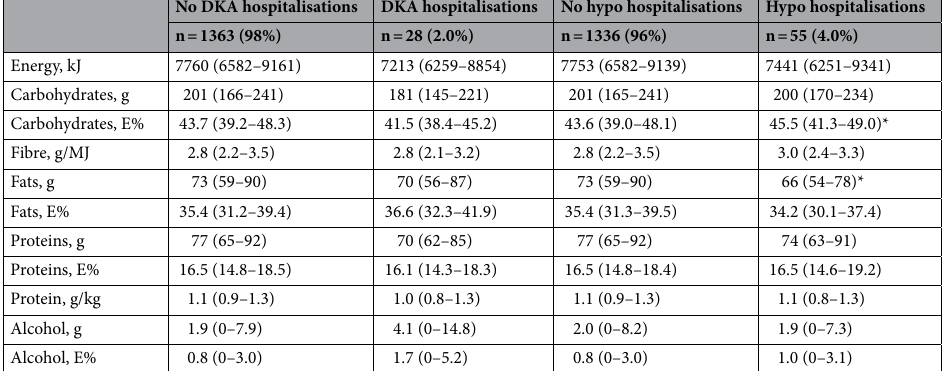
Table 2. Energy, macronutrient, and fibre intakes of the participants divided by hospitalisations. Data are presented as median (interquartile range) for continuous variables with skewed distribution. Mann–Whitney U-test was used for comparing those with each hospitalisation type and those with no hospitalisations. DKA diabetic ketoacidosis, Hypo hypoglycaemia, E% percentage of total energy intake. * p < 0.05.